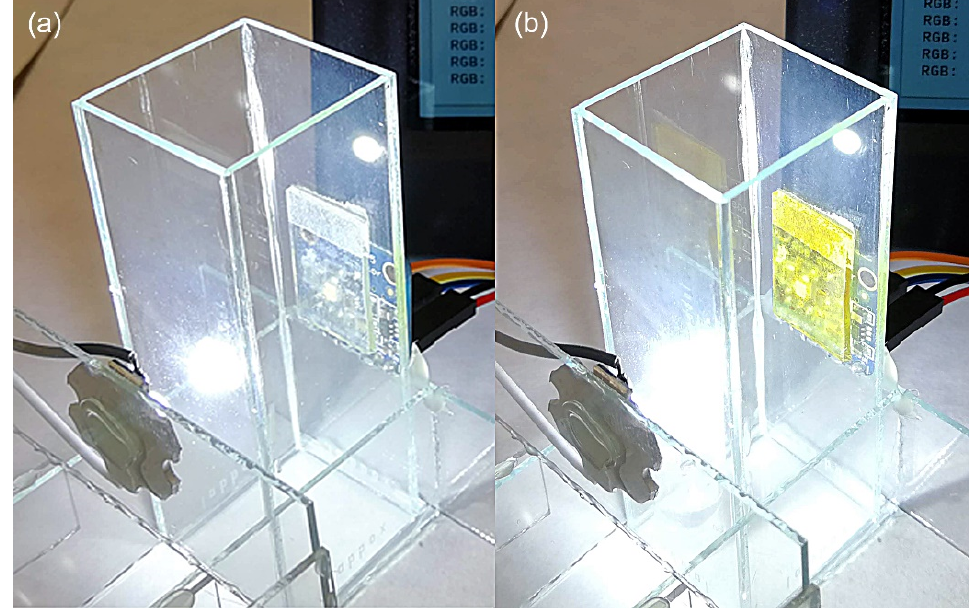
Figure 3. Screen-printed TiO 2 films containing Harrison’s reagent. ( a ) Initial status in air. ( b ) After exposure to phosgene vapors.